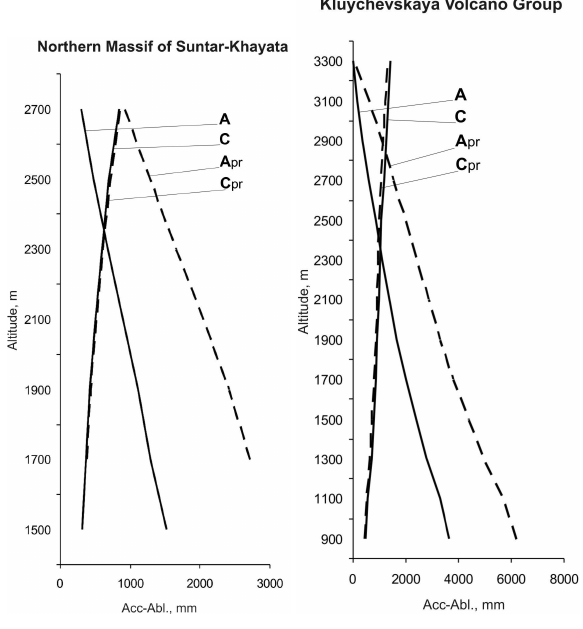
Fig. 4. Mass balance (accumulation and ablation, directed in op- positional way) vertical profiles for one glacier system of northeast Siberia – northern massif of Suntar-Khayata (a) and Kamchatka – Kluychevskaya Volcano (b) . Solid lines – baseline period, broken line – projection by ECHAM4, the keys at the profiles see in the